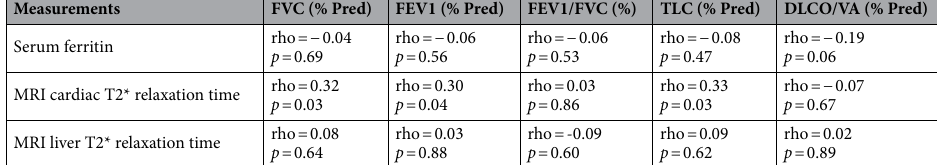
Table 3. Correlations between lung function and surrogate indexes of body iron content. Correlations were performed by Spearman’s rank correlation. FVC, forced vital capacity; FEV1, forced expiratory volume in 1 s; TLC, total lung capacity; DLCO, diffusing capacity of the lung for carbon monoxide; VA, alveolar volume; MRI, magnetic resonance imaging.